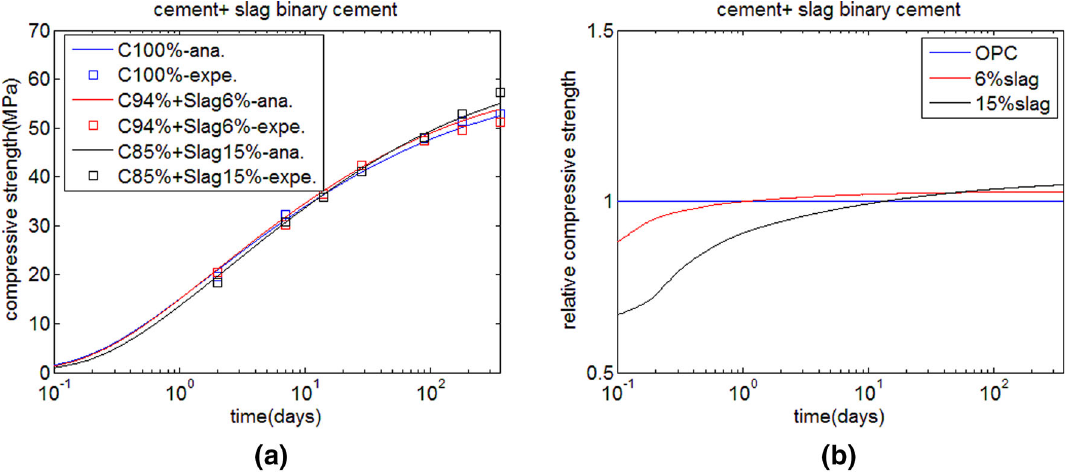
Fig. 8 Strength development of slag blended concrete. a strength development, b relative